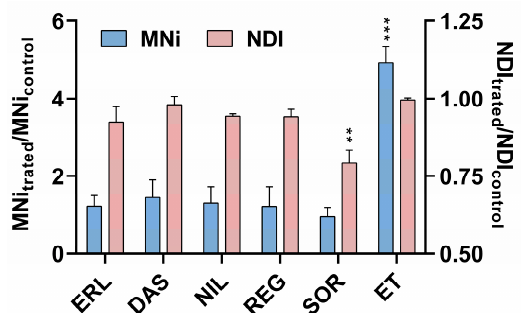
Figure 6. Induction of MN in ZFL cells after 72 h of exposure to TKIs as evaluated by cytokinesis- block micronucleus (CBMN) assay. The frequency of micronucleated (MNed) cells was determined in 1000 binucleated ZFL cells per replicate and experimental point. Etoposide (ET; 0.17 µ M) was used as a positive control. The significant difference in the number of MNed cells between treated and control cells was determined with χ 2 test ** p < 0.001; *** p < 0.0001. Data in the figure are presented as the ratio of MNi between the treated and control cells from three independent experiments ± SD.